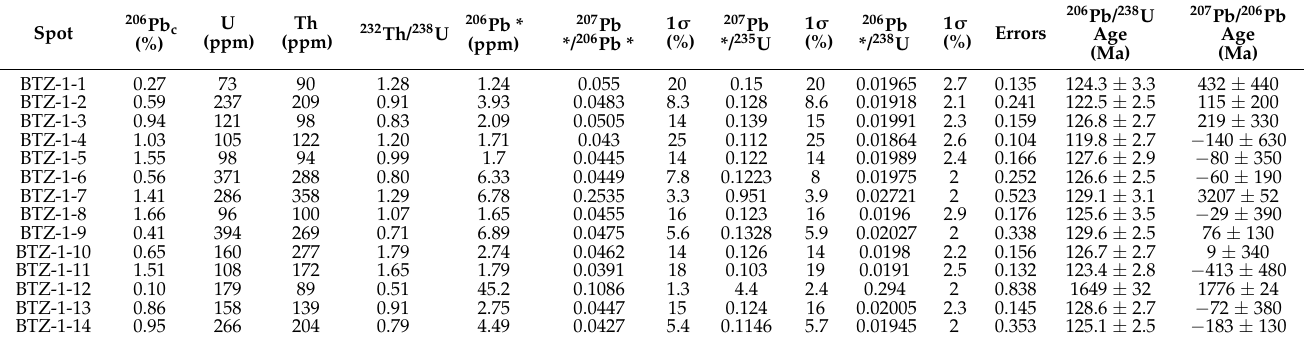
Table 2. Zircon SHRIMP U-Pb data of the monzodiorite